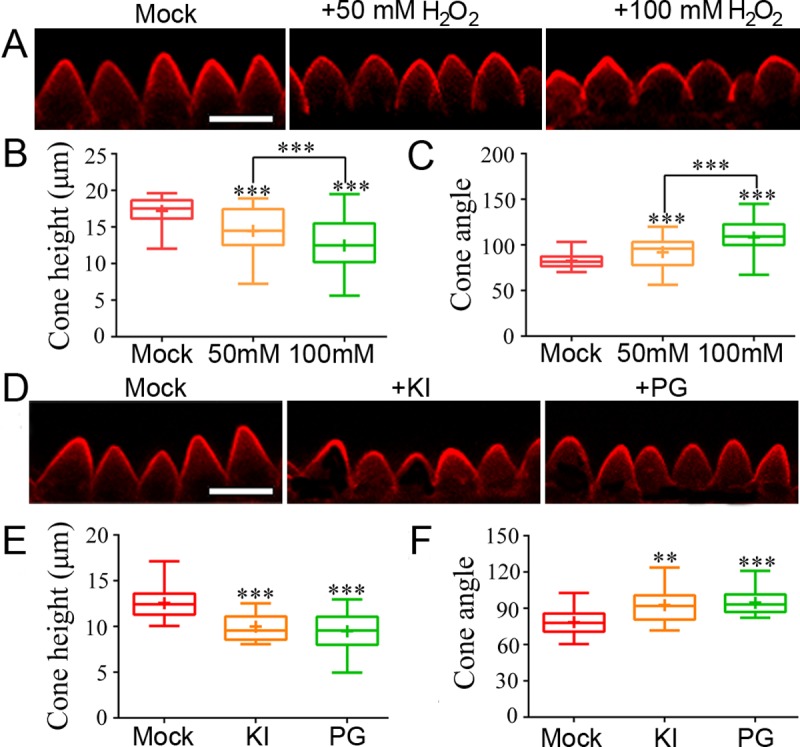
ROS homeostasis is essential for normal conical cell expansion.(A) Exogenously supplied H2O2 leading to reduced tip sharpening of conical cells. WT flower buds at stage 7 were treated by mock, 50 mM H2O2, and 100 mM H2O2, respectively. Conical cells from stage 14 mature petals were visualized by confocal. Scale bar represents 20 μm. (B and C) Boxplots of cone height (B) and cone angle (C) of conical cells. For the quantification of cone height, asterisks indicate a significant difference (Mann–Whitney U test, ***P < 0.001) (P = 0.00018, P = 0.00013, P = 0.00056, respectively). For the quantification of cone angle, asterisks indicate a significant difference (Mann–Whitney U test, ***P < 0.001) (P = 0.00043, P = 0.00019, P = 0.00035, respectively). For all data sets used for quantifications, n = 120 cells from 10 petals. (D) Reduced endogenous ROS levels causing reduced tip sharpening of conical cells. WT flower buds at development stage 7 were exposed to three different treatments: mock, 1 mM KI, and 5 mM n-propyl gallate (PG). Scale bar = 20 μm. (E and F) Quantification of cone height (E) and cone angle (F) of conical cells. For the quantification of cone height, asterisks indicate a significant difference (Mann–Whitney U test, ***P < 0.001) (P = 0.00022, P = 0.00011, respectively). For the quantification of cone angle, asterisks indicate a significant difference (Mann–Whitney U test, **P < 0.01, ***P < 0.001) (P = 0.00125, P = 0.00016, respectively). For all data sets used for quantifications, n = 120 cells of 20 petals. For the boxplots, the box extending from the lower to upper quartile values of the data, with a line representing the data medians. The whiskers extending past 1.5 of the interquartile range.